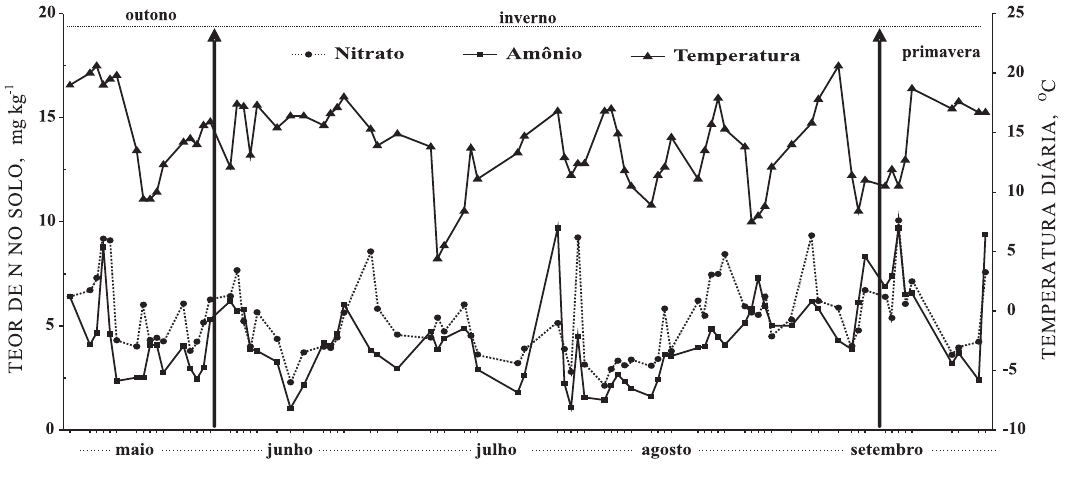
- ) nas amostragens 3